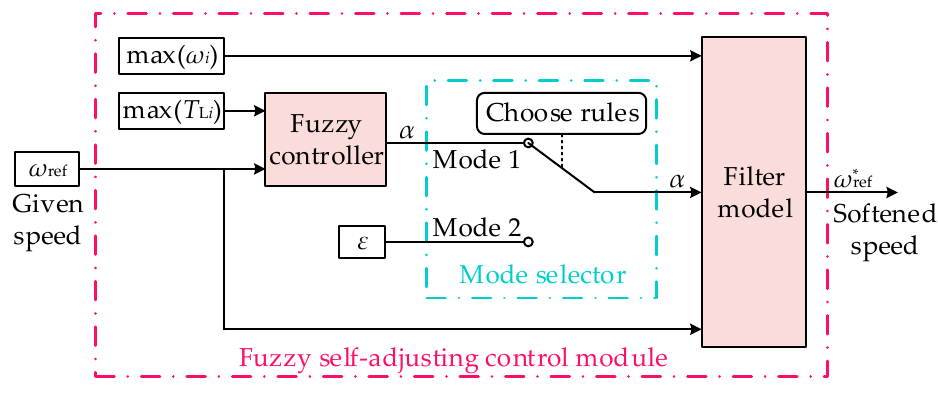
Figure 4. Fuzzy-self-adjusting control module.